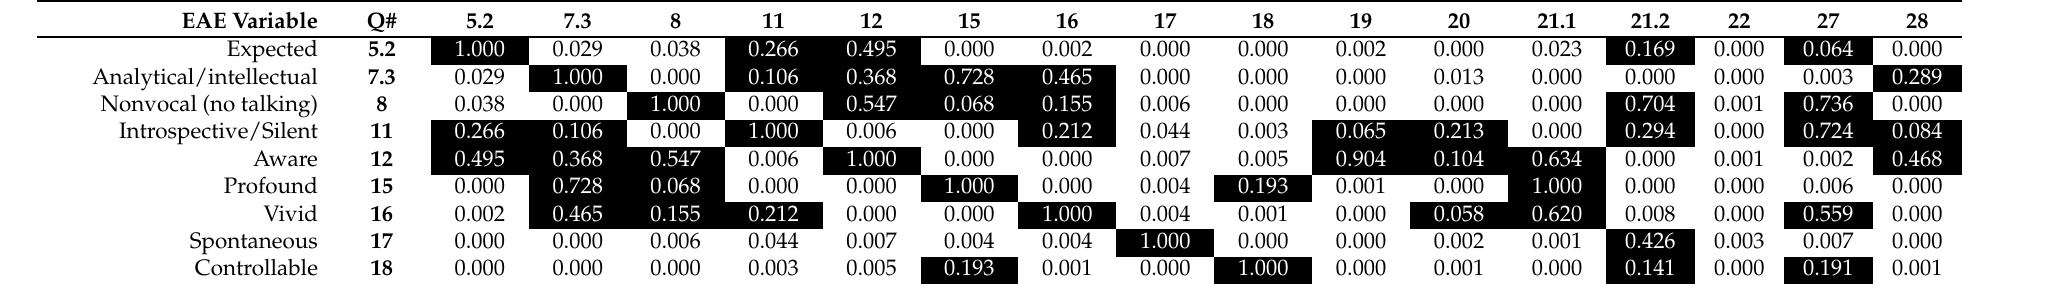
Table A2. Chi-Square test correlation matrix for “extraordinary architectural experience” (EAE) variables from Bermudez’s survey database and reorganized under Jones’ “contemplation” category for ritual contexts. Any variable with a white background (not black) is considered a statistically significant